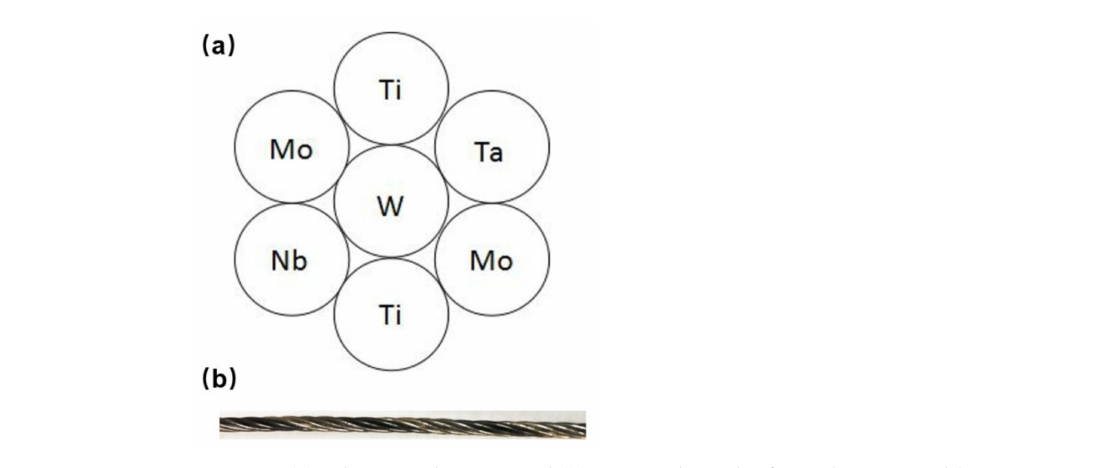
Figure 1. ( a ) Schematic diagram and ( b ) prepared graph of MoNbTaWTi welding wire. The forming process experiment was performed at a feeding speed of 4.5 m/min, surfacing speeding of 0.3 m/min, shielding gas flow of 10 L/min, surfacing current of 280 A, and surfacing voltage of 29 V, after pretreatment process on the substrate, via Pulse MIG- 500II (KEMPPI Company, Lahti, Finland). A self-made argon shield case was employed to prevent oxidation during experimentation. The ambient temperature oscillated around 20 ◦